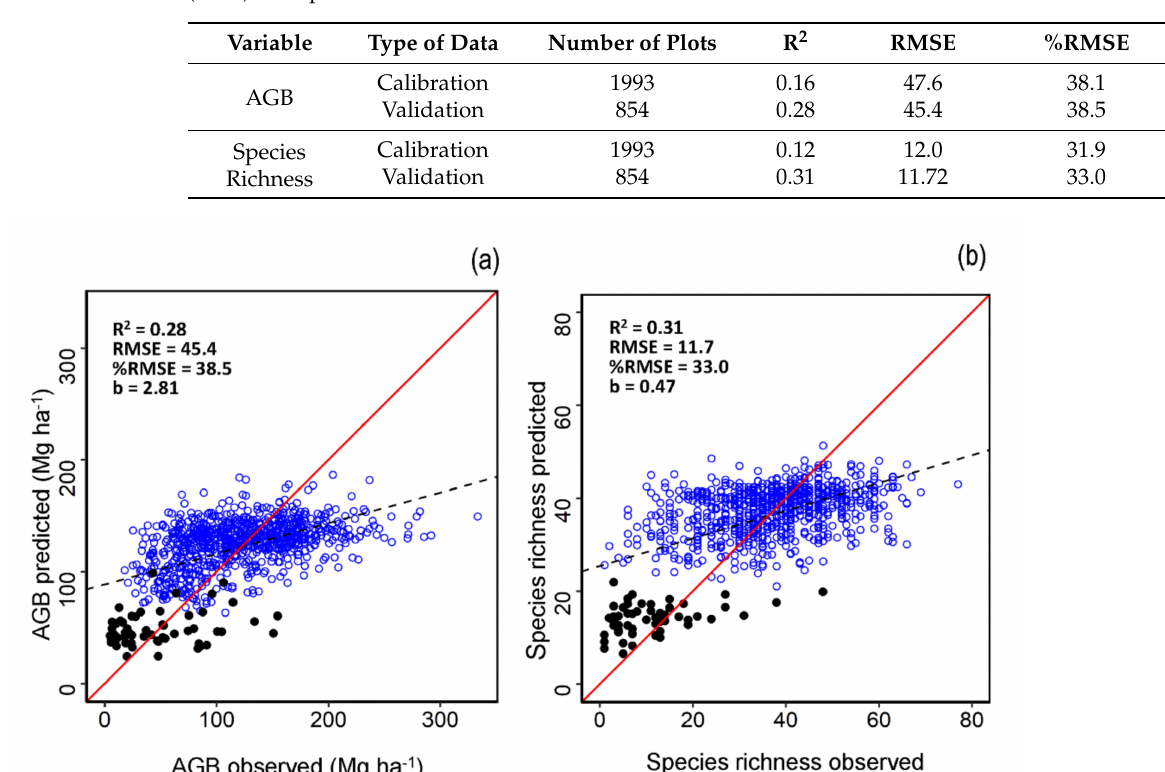
Table 2. Random forest statistics for calibration and validation models of aboveground biomass (AGB) and species richness.